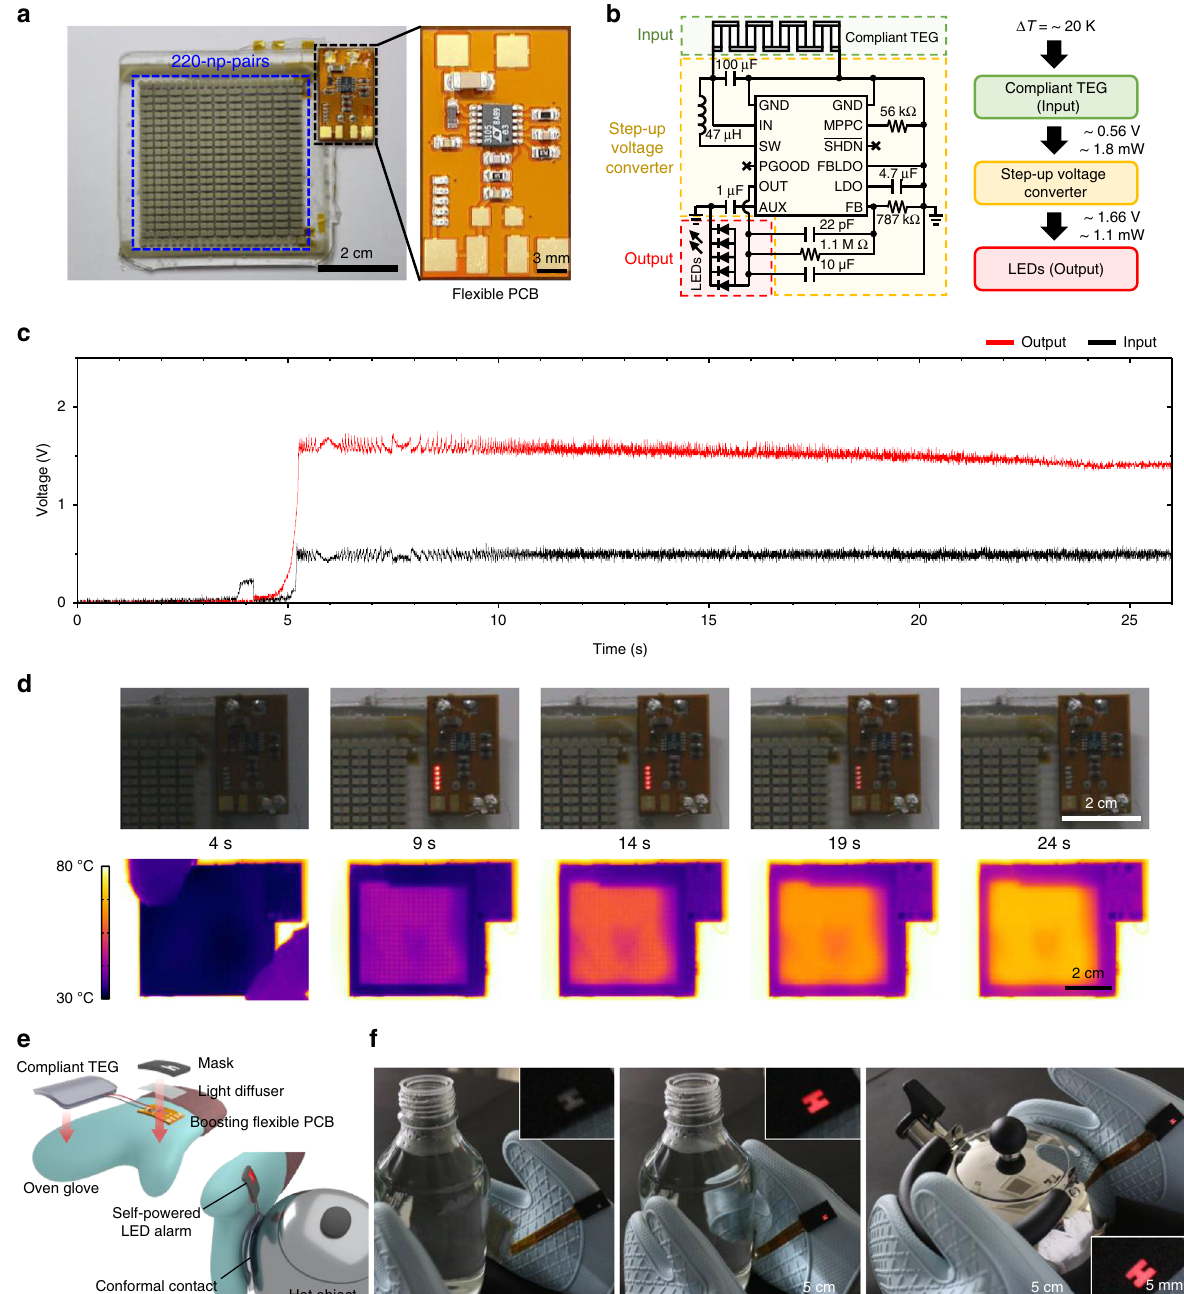
Fig. 6 Self-powered wearable applications with a high-performance compliant TEG. a Photograph of the large-area compliant TEG and an fl exible printed circuit board (f-PCB) with a step-up voltage converter and fi ve light-emitting diodes (LEDs). The right photograph is enlarge view of the f-PCB. Scale bar, 2 cm and 3 mm. b Circuit diagram and optical image of the f-PCB for step-up voltage conversion and LED operation. The block diagram shows an operating sequence with the output voltage and power after each block. c Input and output voltages of the step-up converter when the TEG was put on a hot plate. d Real-time optical and infrared images of the compliant TEG with a step-up voltage converter after the TEG was put on a hot plate. The photographs show that the LEDs was turned on immediately after the TEG was in contact with the hot plate. The infrared images show the temperature of the upper surface of the TEG. Scale bars, 2 cm. e Schematic illustration of hot surface warning gloves with a self-powered LED system and light masking packages. f Photographs showing a demonstration of the TEG-attached gloves when they are used to grasp various hot objects such as a bottle and a kettle. The insets show enlarged view of the self-powered system and packages. The conformal contact between the TEG-attached gloves and the 3D surfaces of the heat sources results in a bright “ H ” sign without any assistance from an external power supply. Scale bars, 5, 5 cm, and 5 Soft heat transfer and electrical interconnection platform . Before depositing patterned metal mask and a portable airbrush (DH-125, Sparmax). Ag – Ni particles were mixed in PDMS and curing agent with 10:1 in a weight ratio using a paste AgNW electrodes, surface treatment with vapor-deposited FOTS was conducted on mixer (ARE-310, Thinky). The Ag – Ni particles/PDMS precursor mixture was a 125- μ m-thick PEN carrier substrate to ensure suf fi cient hydrophobic properties poured onto an FOTS-treated 400- μ m-thick glass substrate with 120- μ m-thick that facilitate detachment of the AgNW electrodes. On the prepared PEN substrate, spacers. The prepared AgNW-coated PEN was placed on top of the mixture. The which was on a 70°C hot plate, 2mL of a AgNW solution was spray-coated using a